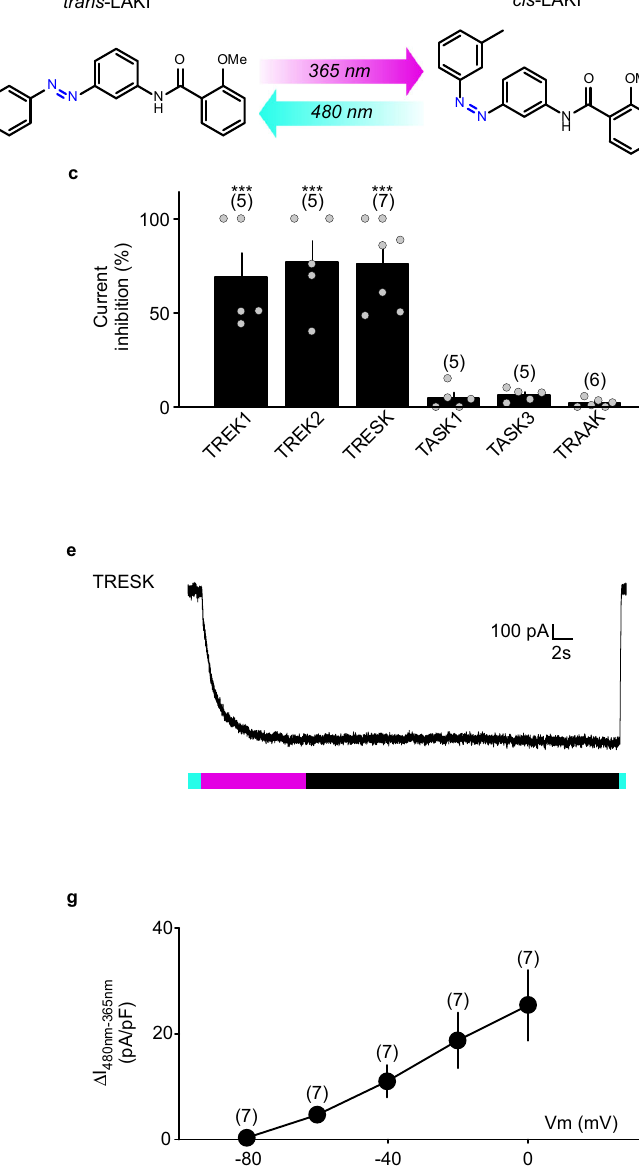
concentrations of LAKI upon alternating illuminationat480nm (blue) and 365nm (magenta). e Representative whole-cell current recording elicited at 0mV from HEK293T expressing TRESK in the presence of LAKI (5 µ M) upon illumination at 480nm(blue)and365nm(magenta)orinthedark. f Whole-cellcurrentrecordings elicitedatdifferentholdingpotentialsfromHEK293TcellsexpressingTRESKinthe presenceofLAKI(5 µ M)uponalternatingilluminationat480nm(blue)and365nm (magenta). g IV relationship of the photocurrent density induced by alternating illumination (I 480nm – I 365nm ) at different holding potentials in HEK293T cells expressing TRESK in the presence of LAKI (5 µ M). n was obtained from one experiment.Datawererepresentedasmean±SEM.Thenumbersoftestedcellsare indicated in parentheses on the